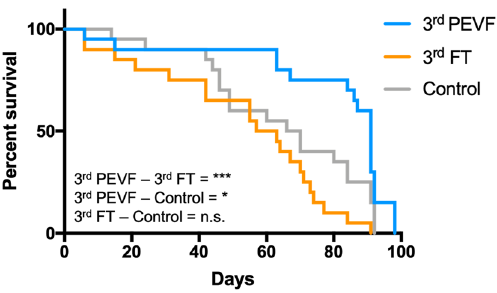
Figure 8. The survival of D. magna when exposed to weekly doses of the HDPE breakdown fractions. The PEVF is concentrated two times compared to toxicity test 1, and FT concentration is below 1% compared to D. magna test 1. Asterisks indicate significant difference from a control group, *p < 0.05, ***p <